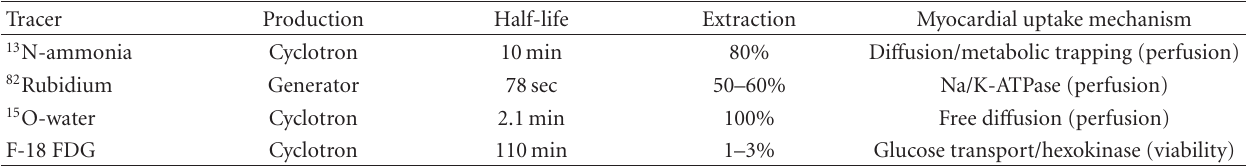
Table 2: Principal characteristics of PET tracers for cardiovascular imaging.